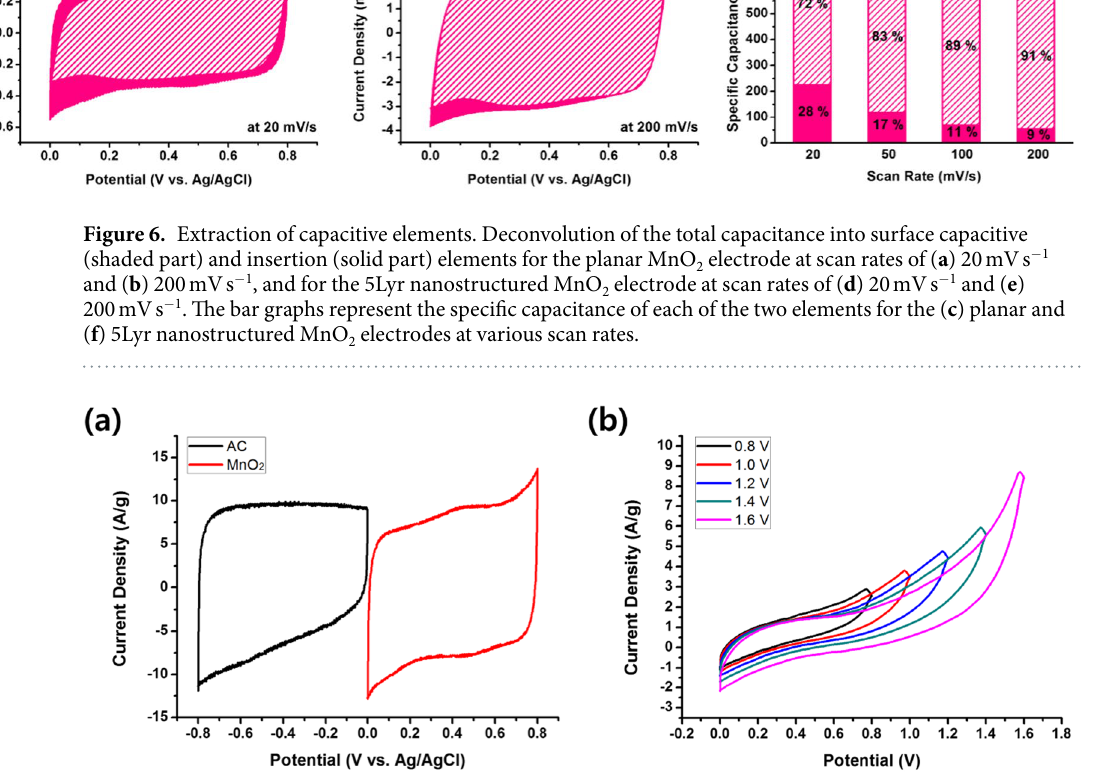
nanowires 16 and 66% at 20 mV s − 1 and 55% at 100 mV s − 1 for Mn 3 O 4 nanoparticles 25 . In contrast, in the case of the